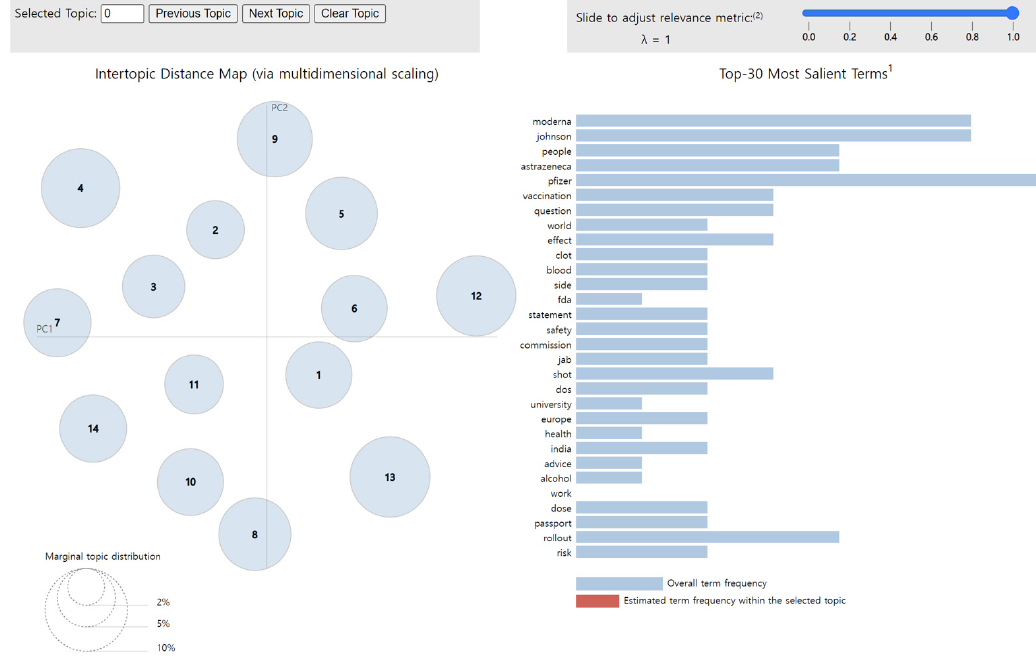
Figure 4. Bubble chart and bar graph for data visualization with LDA topic modeling.